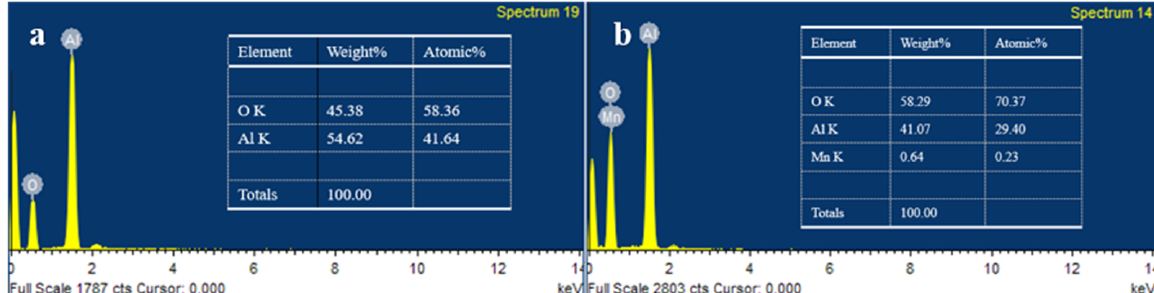
Figure 3. EDS results of AA ( a ) and MnOOH-supported AA particles ( b ).